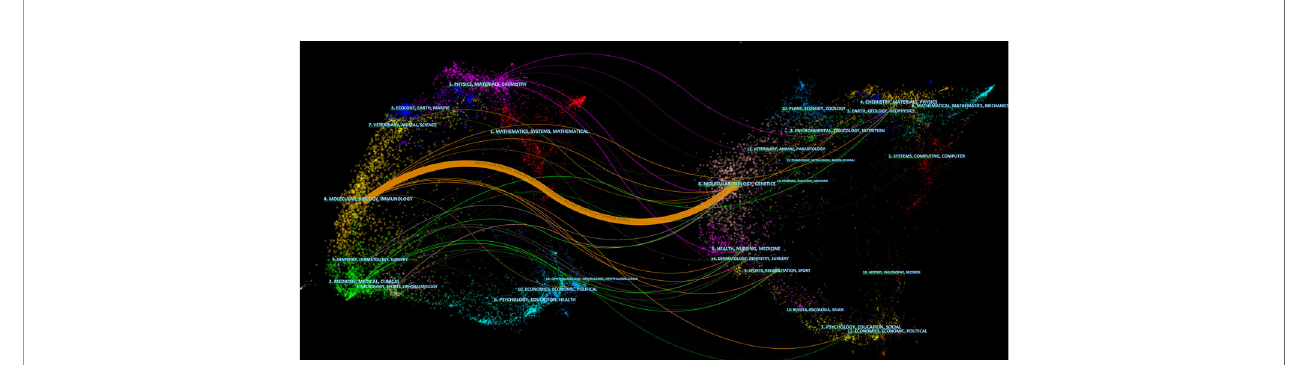
FIGURE 6 | The dual-map overlay of journals on research of exosomes in